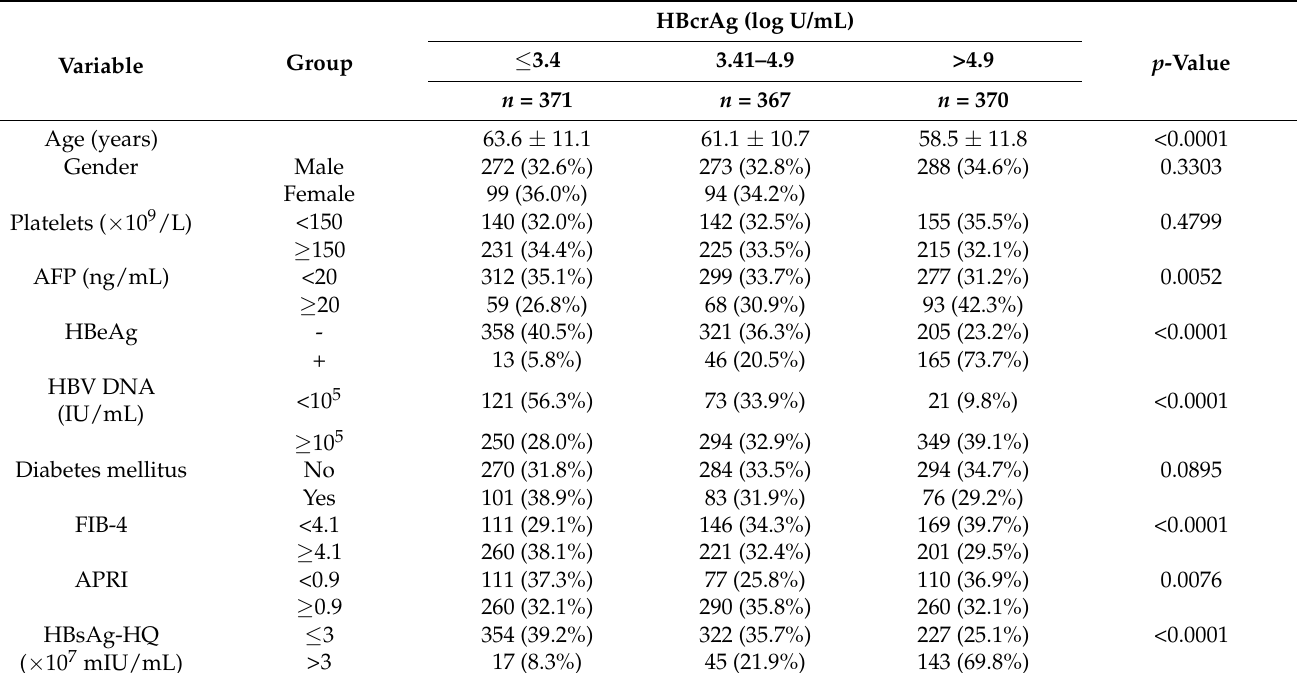
Table 2. The distribution of HBcrAg levels and other